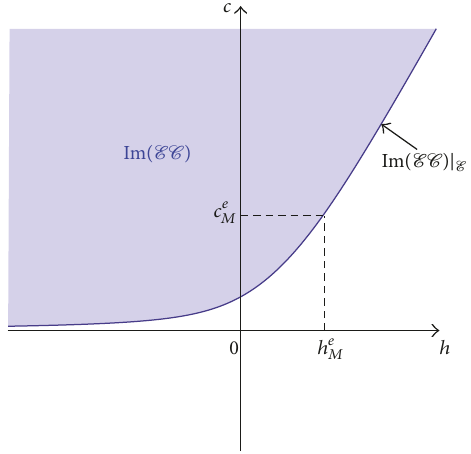
Figure 1: The image of the energy-Casimir mapping.